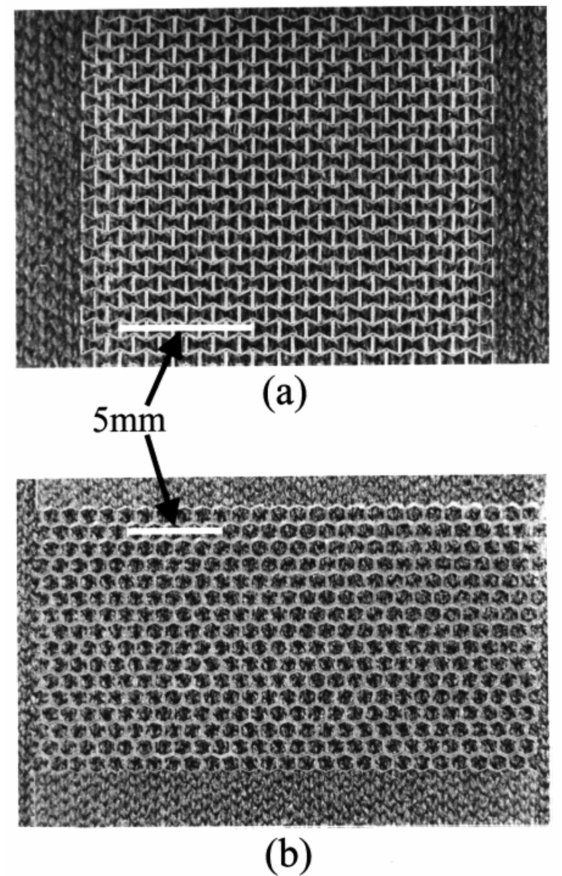
Figure 6. ( a ) Polymeric re-entrant honeycomb membrane; ( b ) polymeric conventional honeycomb membrane. Pores are approximately 1 mm in width (along the x direction). The membranes were fabricated by direct femtosecond laser ablation in air, with pulses at 790 nm (170 fs). Provided with permission from American Chemical Society [55].